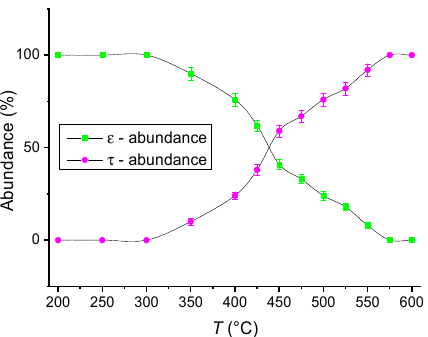
Figure 3. Relative abundance of ε and τ -MnAl, respectively, vs. temperature of the measurement.